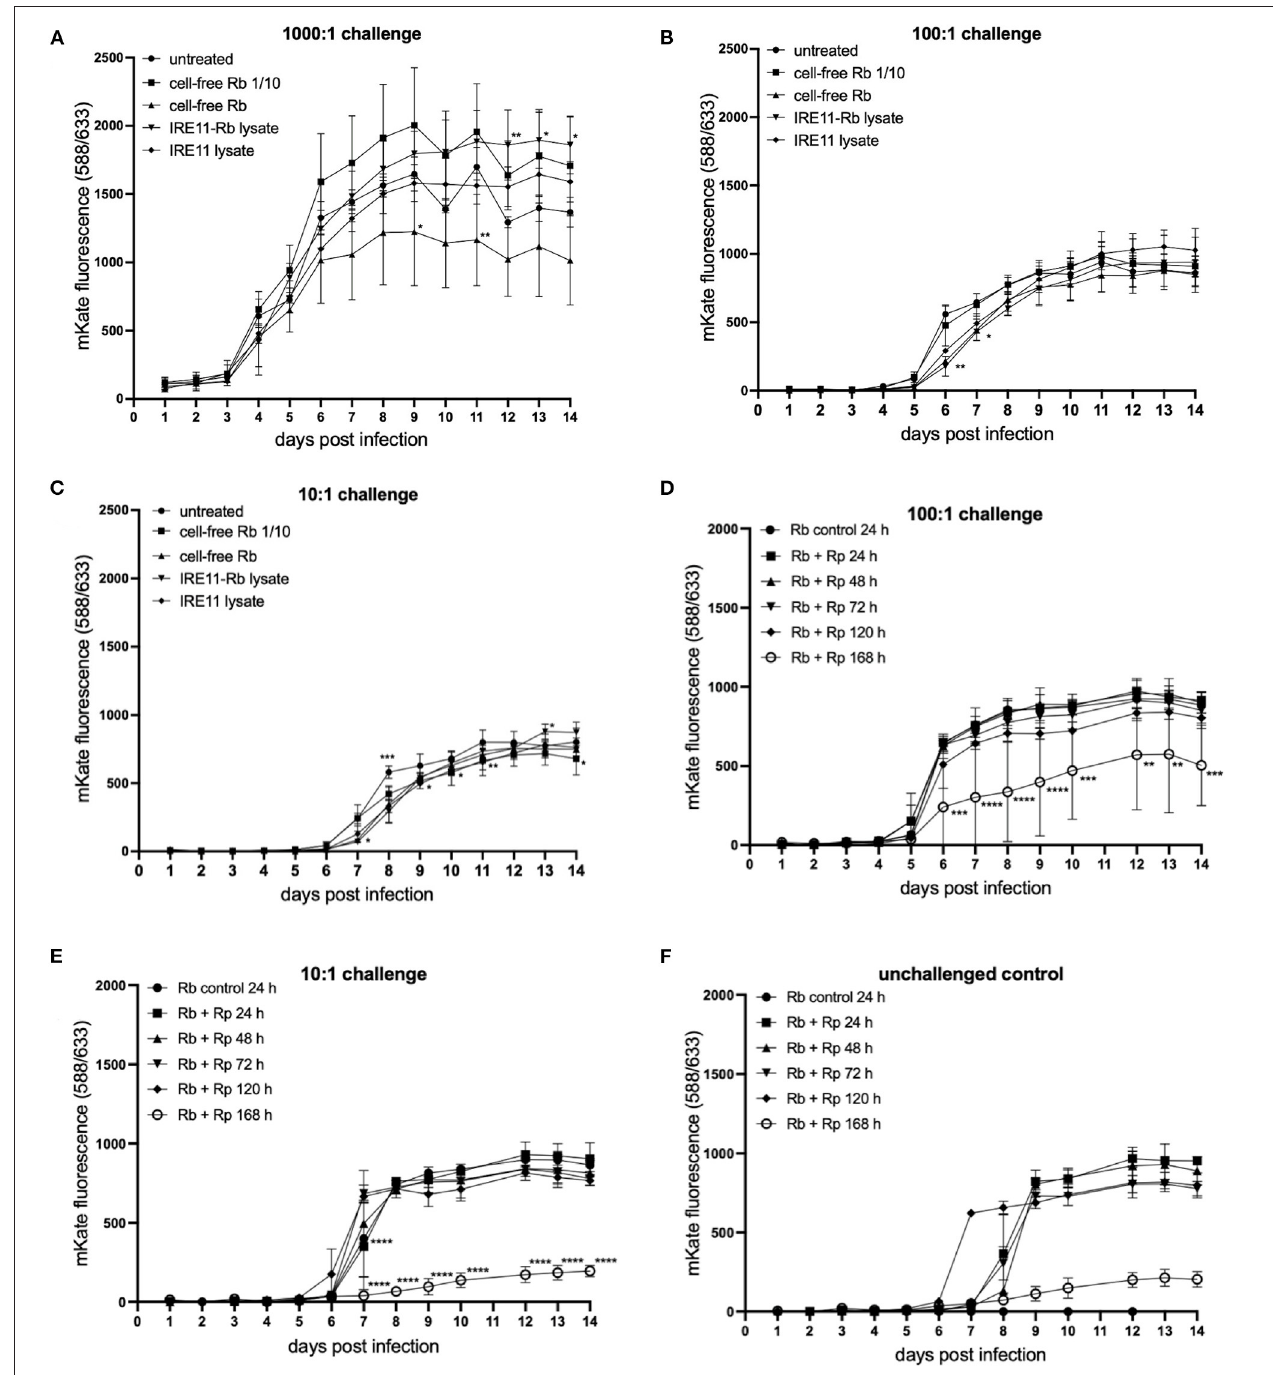
FIGURE 7 | Rickettsia parkeri replication in IRE11 treated with cell-free R. buchneri or R. buchneri lysate. Replication of R. parkeri -mKate in tick cells was monitored for 14 days by measuring mKate fluorescence on a microplate reader. (A–C) R. parkeri- mKate replication in IRE11 at challenge doses of 1,000:1 (A) , 100:1 (B) , and 10:1 (C) in the presence of cell-free R. buchneri , lysate from R. buchneri- infected IRE11, or lysate from uninfected IRE11. (D–F) R. parkeri- mKate replication in IRE11 treated with lysates from R. buchneri challenged with Rp- mKate for 24, 48, 72, 120, or 168h. Treated cells were challenged with 100:1 (D) or 10:1 (E) Rp- mKate. Unchallenged control indicates that viable Rp- mKate are present in cell lysate (F) . Data show mean and error bars standard deviation of three replicate wells. Means were compared to the uninfected control IRE11 using a two-way ANOVA with Dunnett’s multiple-comparison test; statistically significant values are marked by asterisks * p < 0.05, ** p < 0.01, *** p < 0.001, **** p <